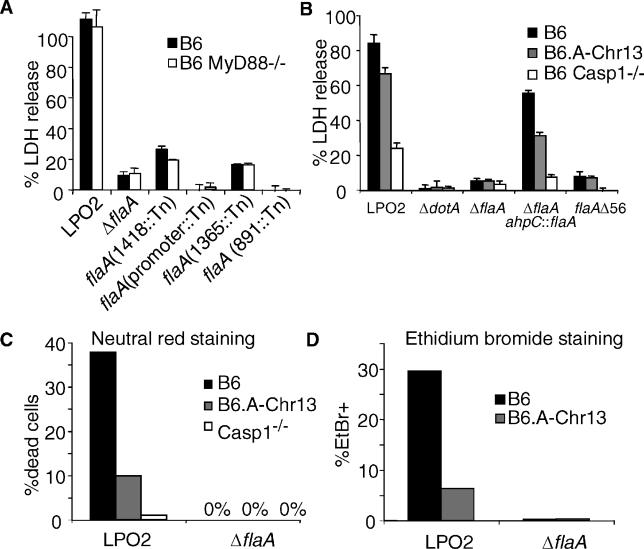
Rapid Lysis of Macrophages in Response to Flagellin-Expressing Legionella
In all experiments shown, bacteria were added at an MOI of 2, and were spun onto the macrophages at 400 g for 10 min. Cells were assayed 4 h after infection. LP02 is the wild-type strain and is isogenic with the mutants utilized in these experiments.(A) Release of the intracellular enzyme LDH by B6 and MyD88−/− macrophages with indicated Legionella strains, including four mutants with transposon insertions in flaA. One hundred percent release is set as the amount of LDH released by detergent-treated macrophages (minus spontaneous release).(B) LDH release by B6, B6.A-Chr13, and B6 caspase-1-deficient macrophages infected with the indicated Legionella strains. FlaAΔ56 is an LP02-derived strain that contains an EMS-induced point mutation in flaA, resulting in a truncation of the last 56 amino acids of FlaA.(C) Cell death of macrophages was assessed by degree of failure to take up neutral red in a 4-h assay. At least 100 macrophages were counted for each condition; one representative experiment of two is shown.(D) Cell death was quantified by assessing permeability to ethidium bromide-2 homodimer. At least 400 macrophages were counted for each condition; one representative experiment of two is shown.